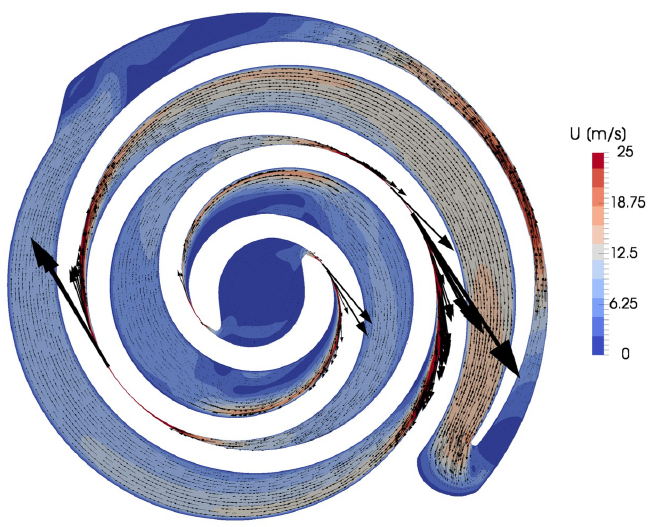
Figure 8. Power variation over a revolution of the shaft.